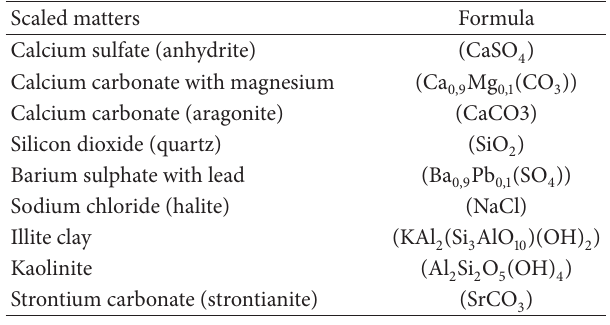
Table 2: Matters observed on surface using XRD analysis.